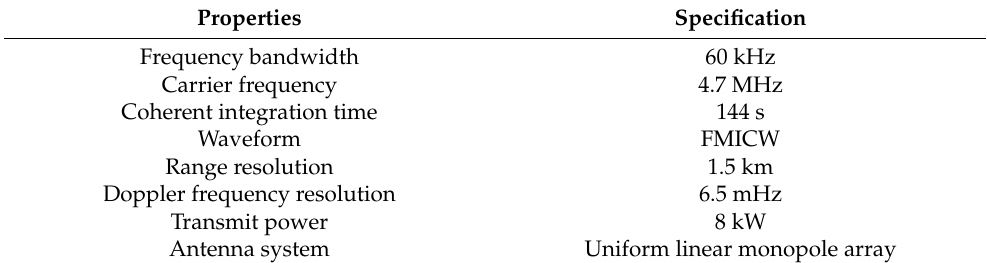
Table 1. The related parameters of the applied HFSWR system.